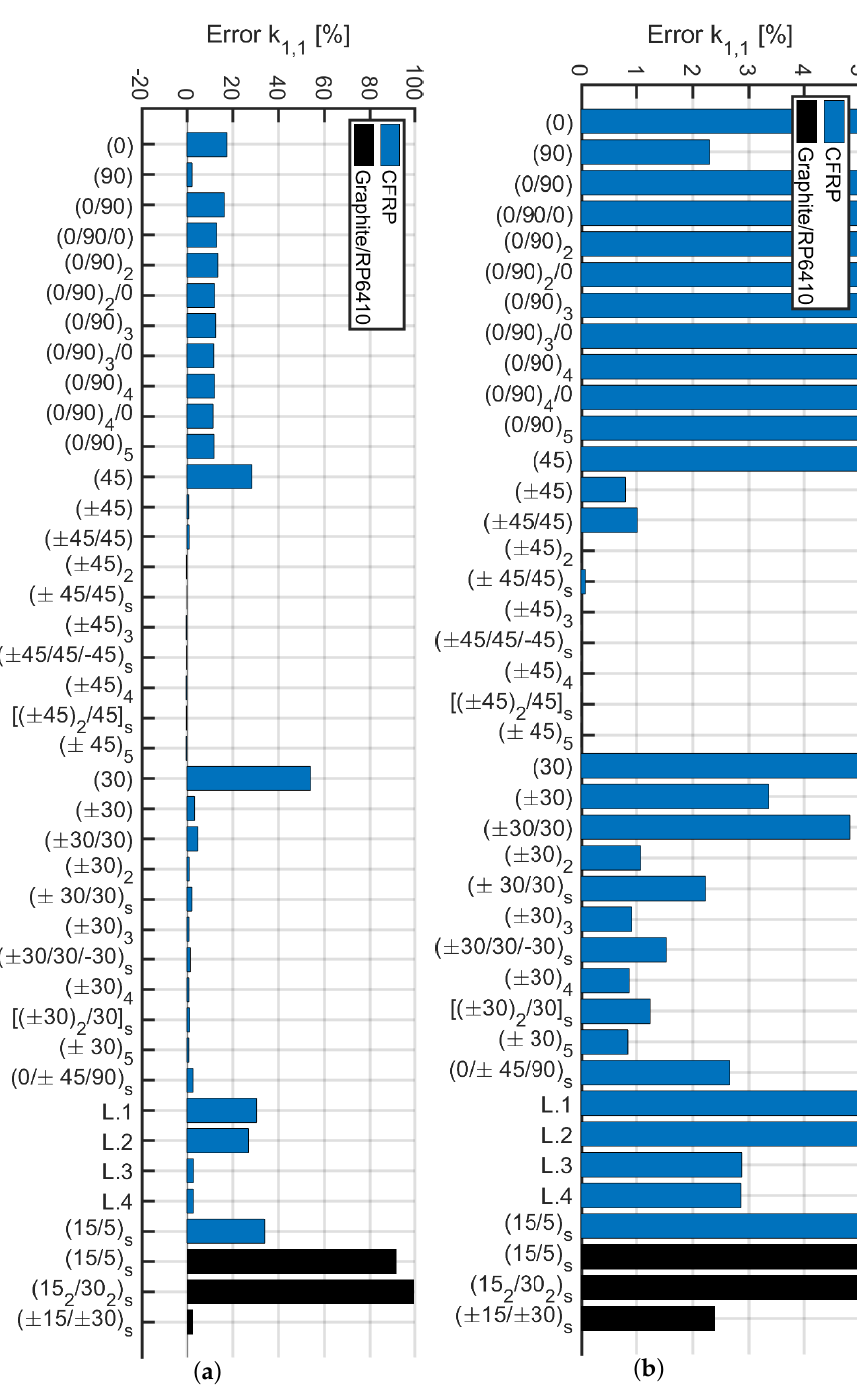
Figure 20. Percentage of error computing k 1,1 with the present methodology: ( a ) overall error; ( b ) the plot limited up to 5% of